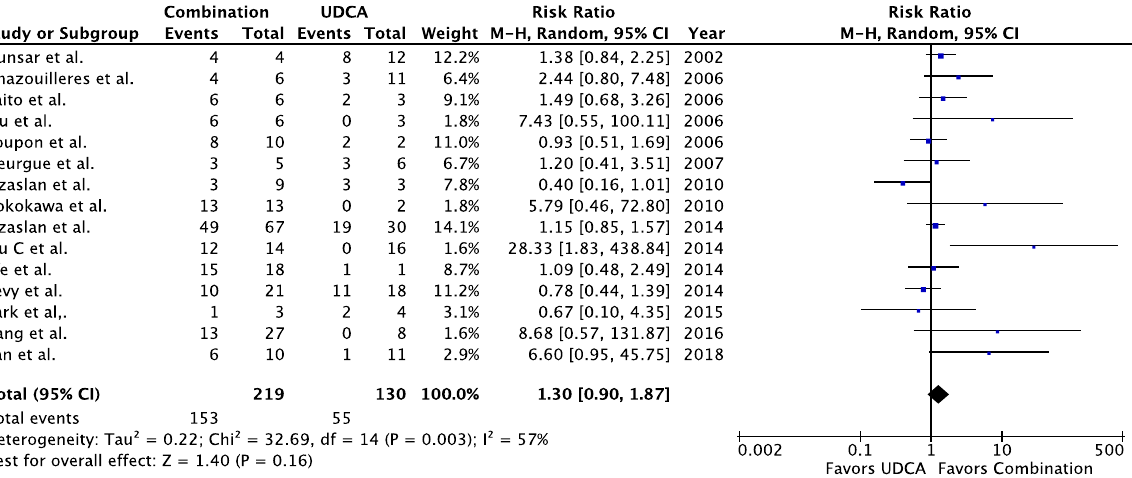
Figure 1. Symptomatic improvement in AIH-PBC patients treated with combination therapy vs. UDCA. UDCA = ursodeoxycholic acid, Combination = UDCA + [corticosteroids and/or antimetabolites].